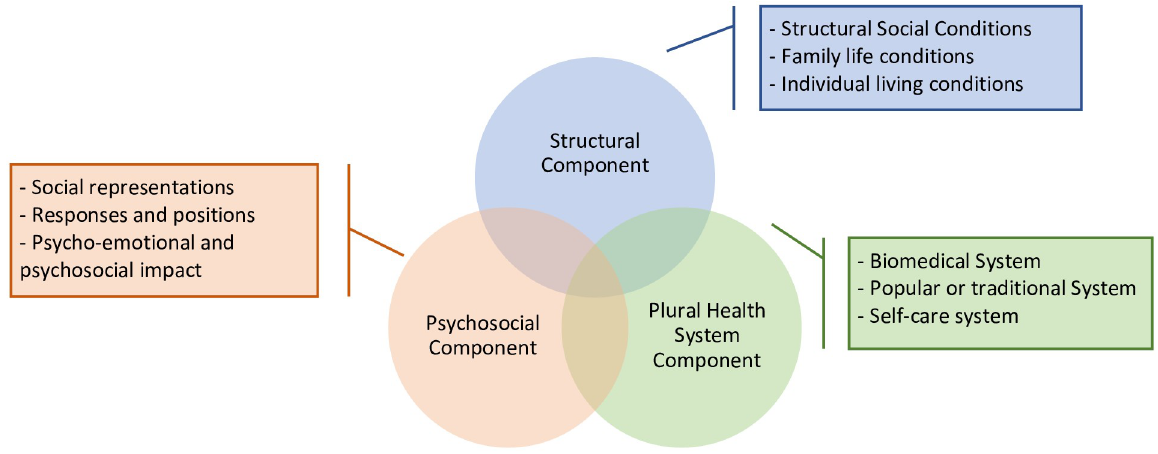
Fig 3. Emerging theoretical